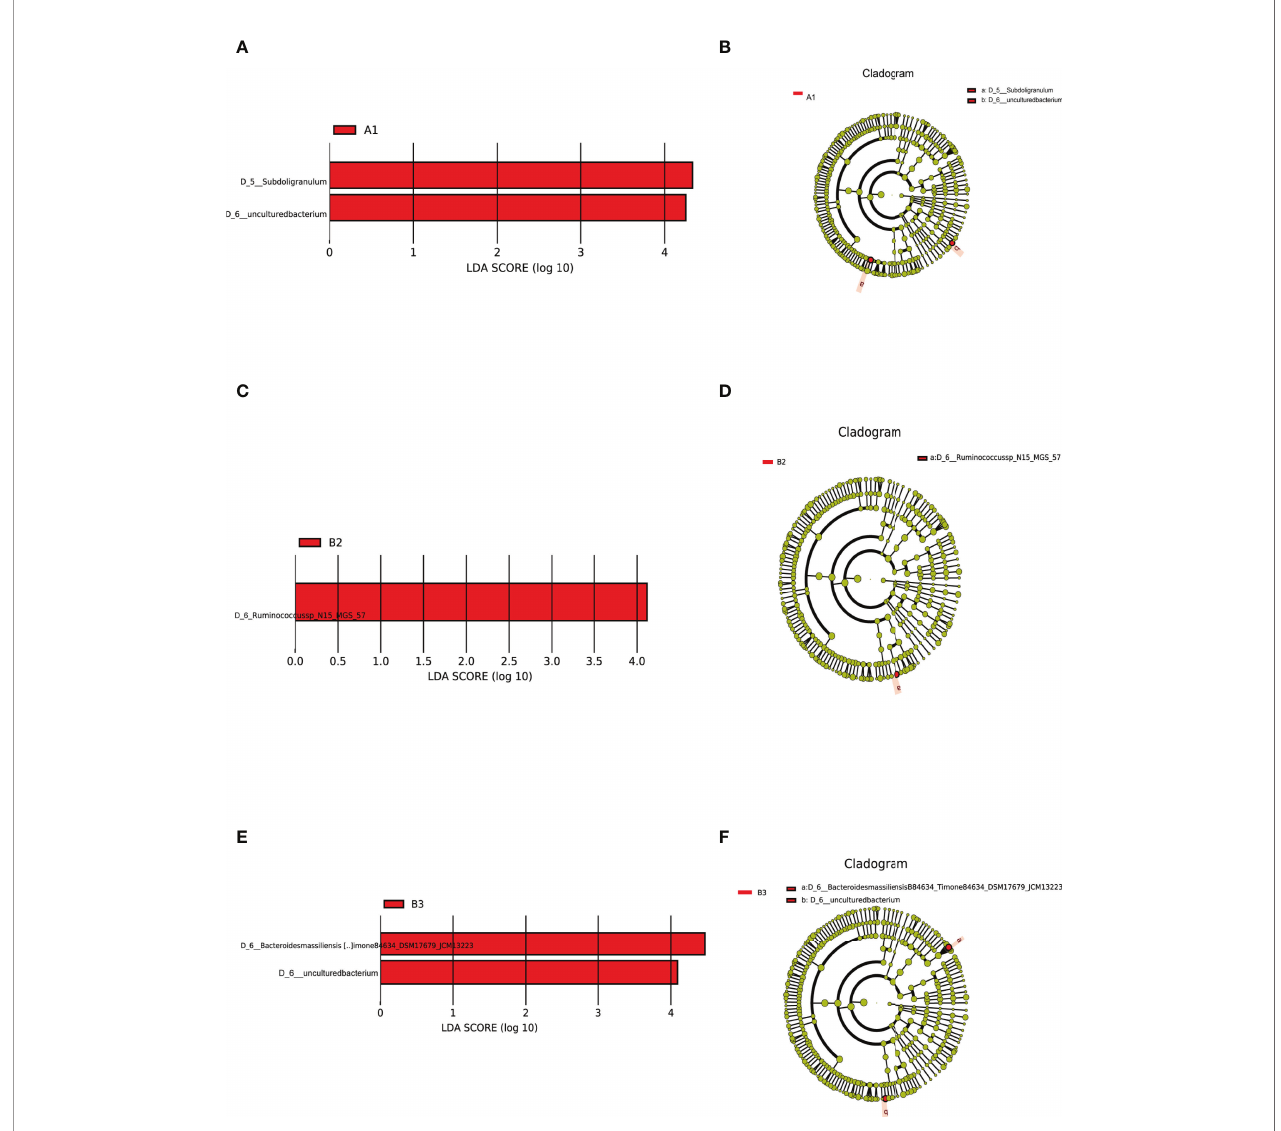
FIGURE 4 | Intestinal fl ora as markers in TPOAb-positive women with SCH. LEfSe analysis of differential species abundance. (A, B) TPOAb-positive vs. TPOAb- negative women with SCH and no LT 4 ; (C, D) TPOAb-positive vs. TPOAb-negative women with SCH and low-dose LT 4 ; (E, F) TPOAb-positive vs. TPOAb-negative women with SCH and high-dose LT 4 . LDA value distribution histogram: red bars indicate higher abundance of intestinal fl ora. Cladograms: circles radiating from the inside to the outside represent taxonomic levels from phylum to species. A1, TPOAb-positive women with SCH and no LT 4 ; A2, TPOAb-positive women with SCH and low-dose LT 4 ; A3, TPOAb-positive women with SCH and high-dose LT 4 ; B1, TPOAb-negative women with SCH and no LT 4 ; B2, TPOAb-negative women with SCH and low-dose LT 4 ; B3, TPOAb-negative women with SCH and high-dose LT 4